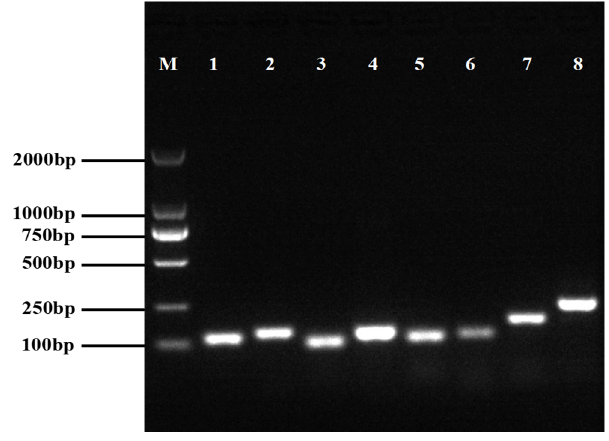
Figure 1. Agarose gel electrophoresis analysis of PCR products of eight reference genes in tomato. M. DL2000 maker, 1. EF1 α , 2. L33 , 3. Act , 4. Ubi , 5. GAPDH , 6. UK , 7. CAC , 8. TIP41 .